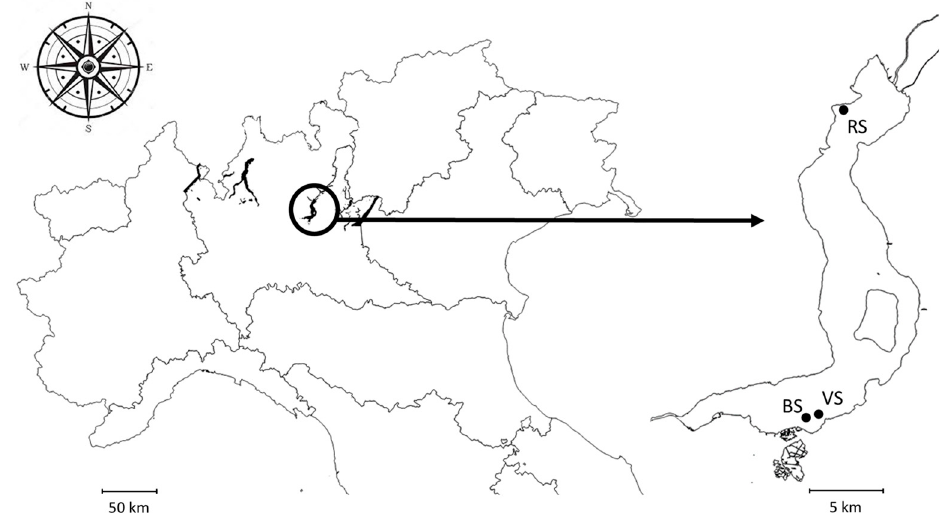
Figure 1. Location of Lake Iseo ( left ), and a detailed map of the lake ( right ) showing the three sampling sites (RS = rocky shore; VS = vegetated sediment; BS = bare sediment).